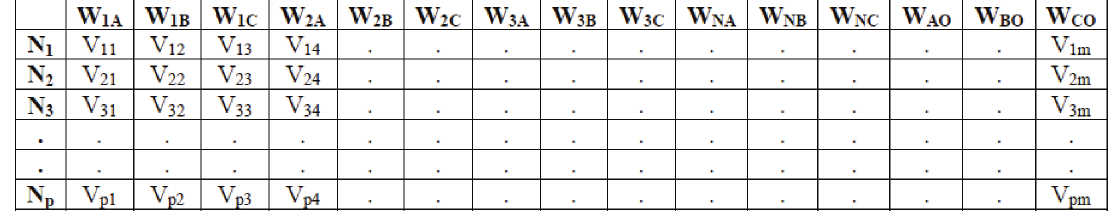
Fig.5. Sample initial solution generated to train neural